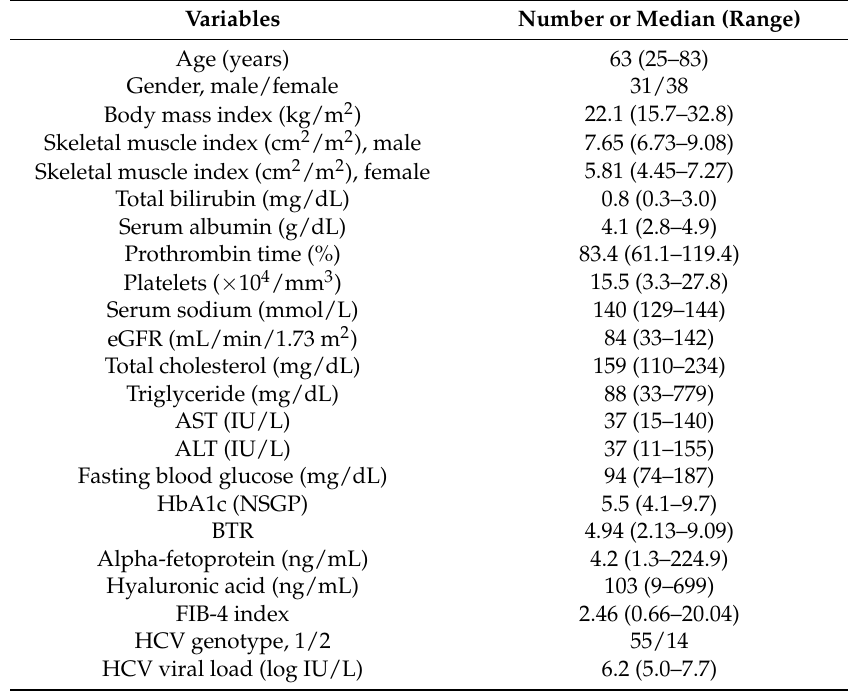
Table 1. Baseline data ( n =